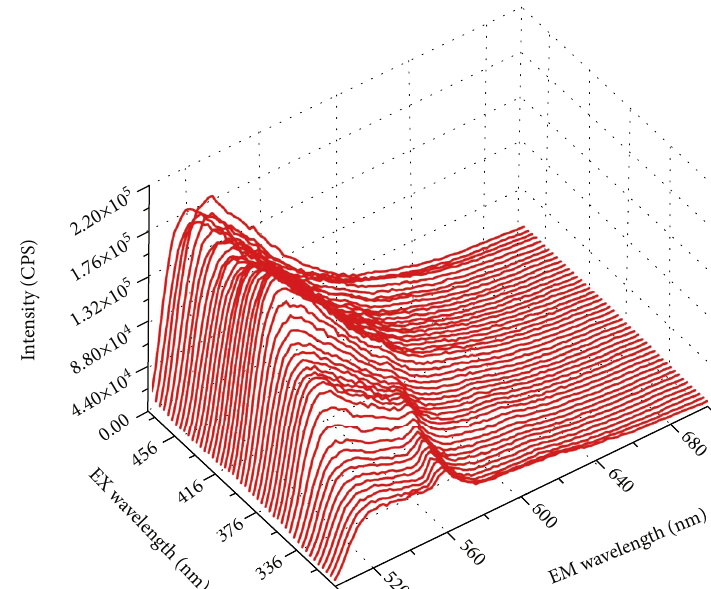
Figure 7: 3D spectrogram of the polymer.